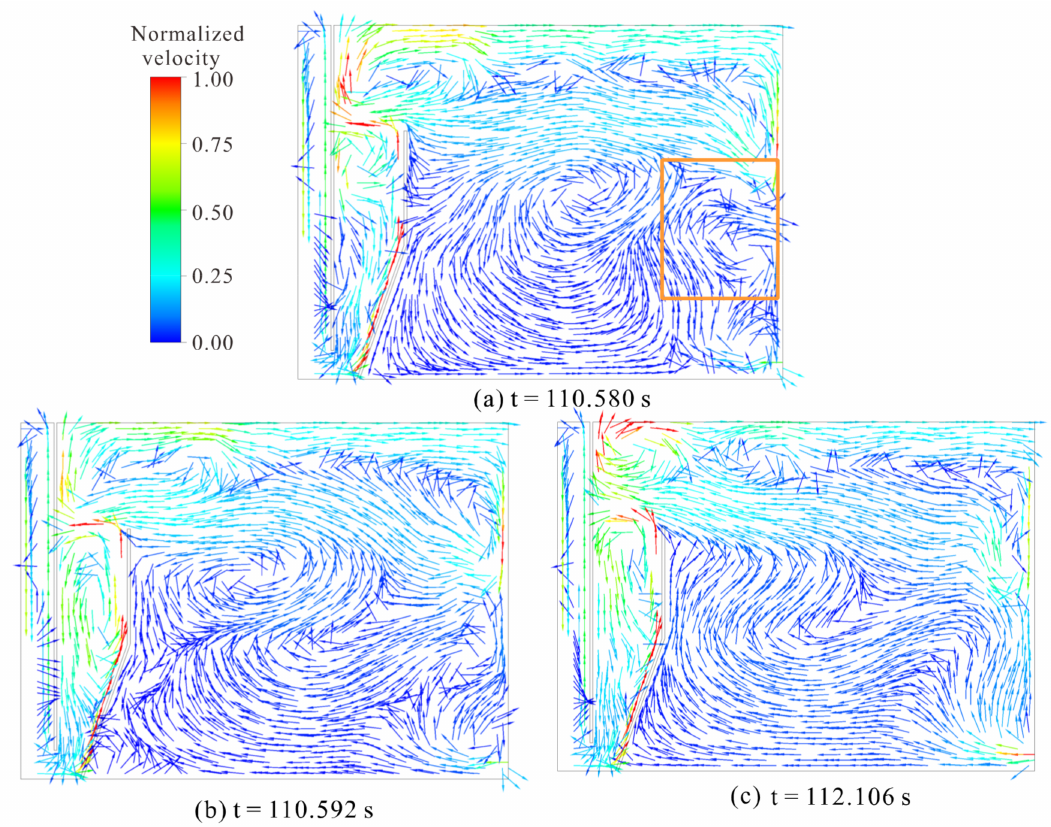
Figure 5. Another switching process from counterclockwise to clockwise.